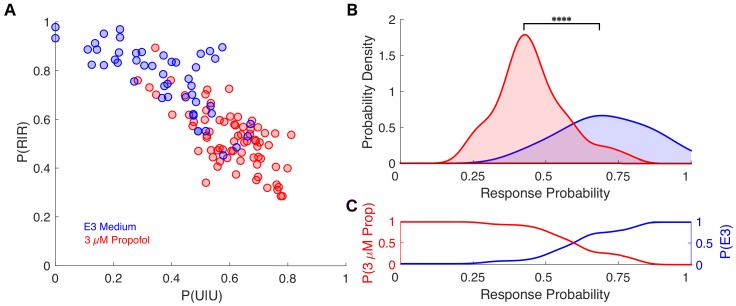
Individual response probabilities between different drug concentrations overlap in zebrafish.(A) Transition probability matrix estimated for each individual is represented by a point in a plane spanned by P(R|R) and P(U|U) for zebrafish exposed to either E3 medium (n=48, blue dots) or 3 μM propofol in E3 medium (n=72, red dots). (B) Probability density functions of average across-trial response probabilities were estimated for E3 alone (blue) and 3 μM propofol (red) from the projection of the transition probability matrices onto the first principal component (PC1) which accounts for ~90% of the variance among individuals. There is a significant difference between the distributions for fish exposed to E3 or 3 μM propofol (U = 324, nE3 = 48, n3μM = 72, p < 0.0001). (C) Posterior distributions computed using Bayes' theorem representing the probability of a zebrafish being exposed to either E3 (blue) or 3μM (red) propofol given the animals response probability. As in mice, over a broad range of average across-trial response probabilities, the odds of correctly identifying the drug concentration on the basis of observed probability of a response in an individual is close to chance for a broad range of response probabilities. Statistical significance is shown by **** p < 0.0001.